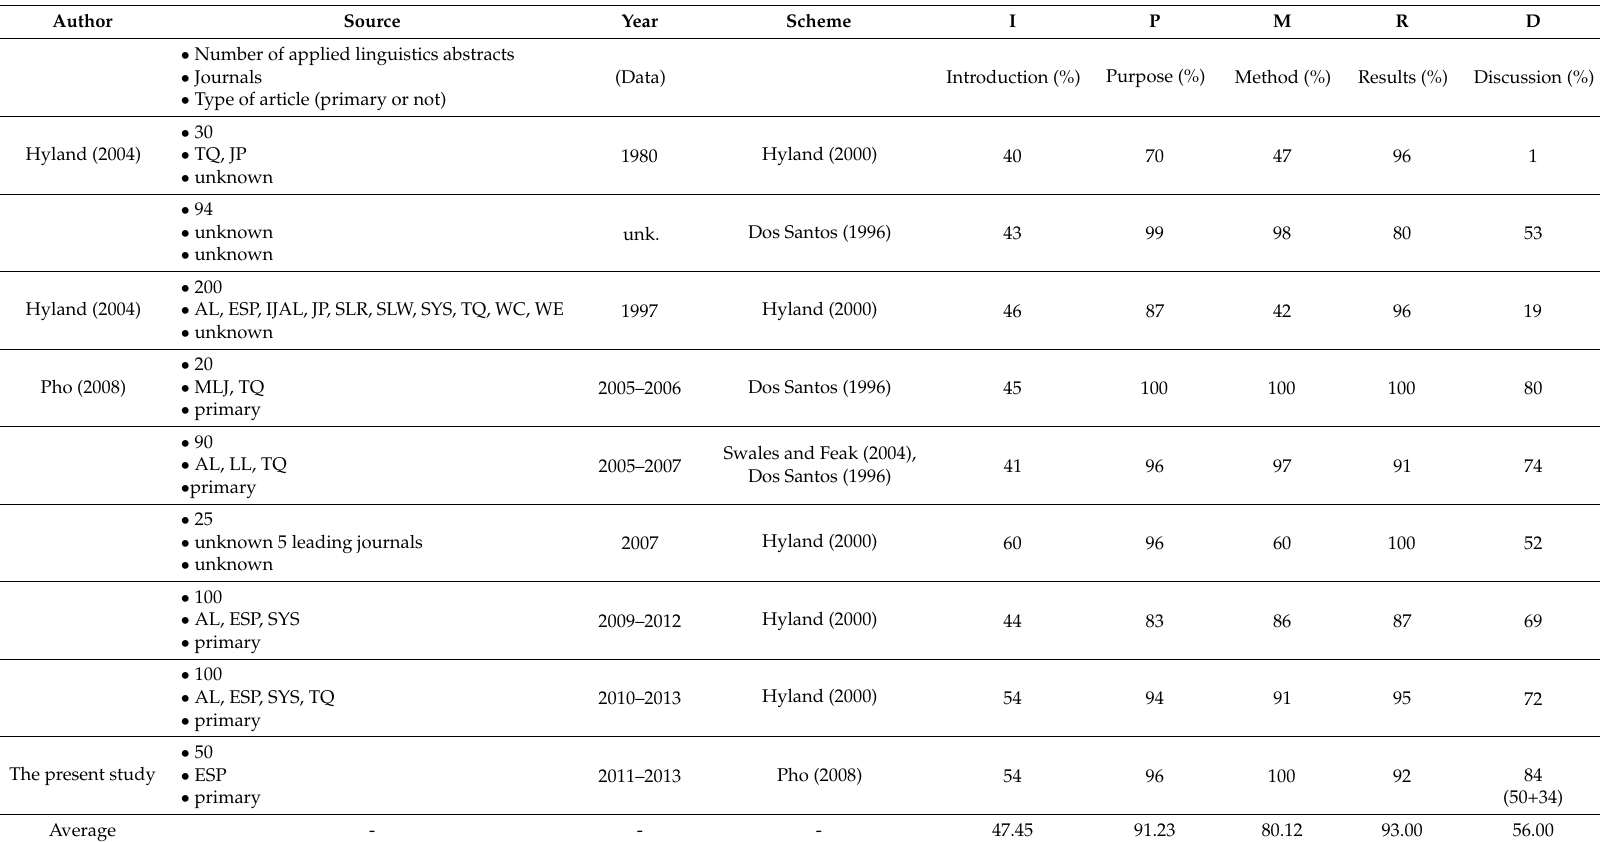
Table 3. Comparison of the move analysis results by the present and previous studies on applied linguistics